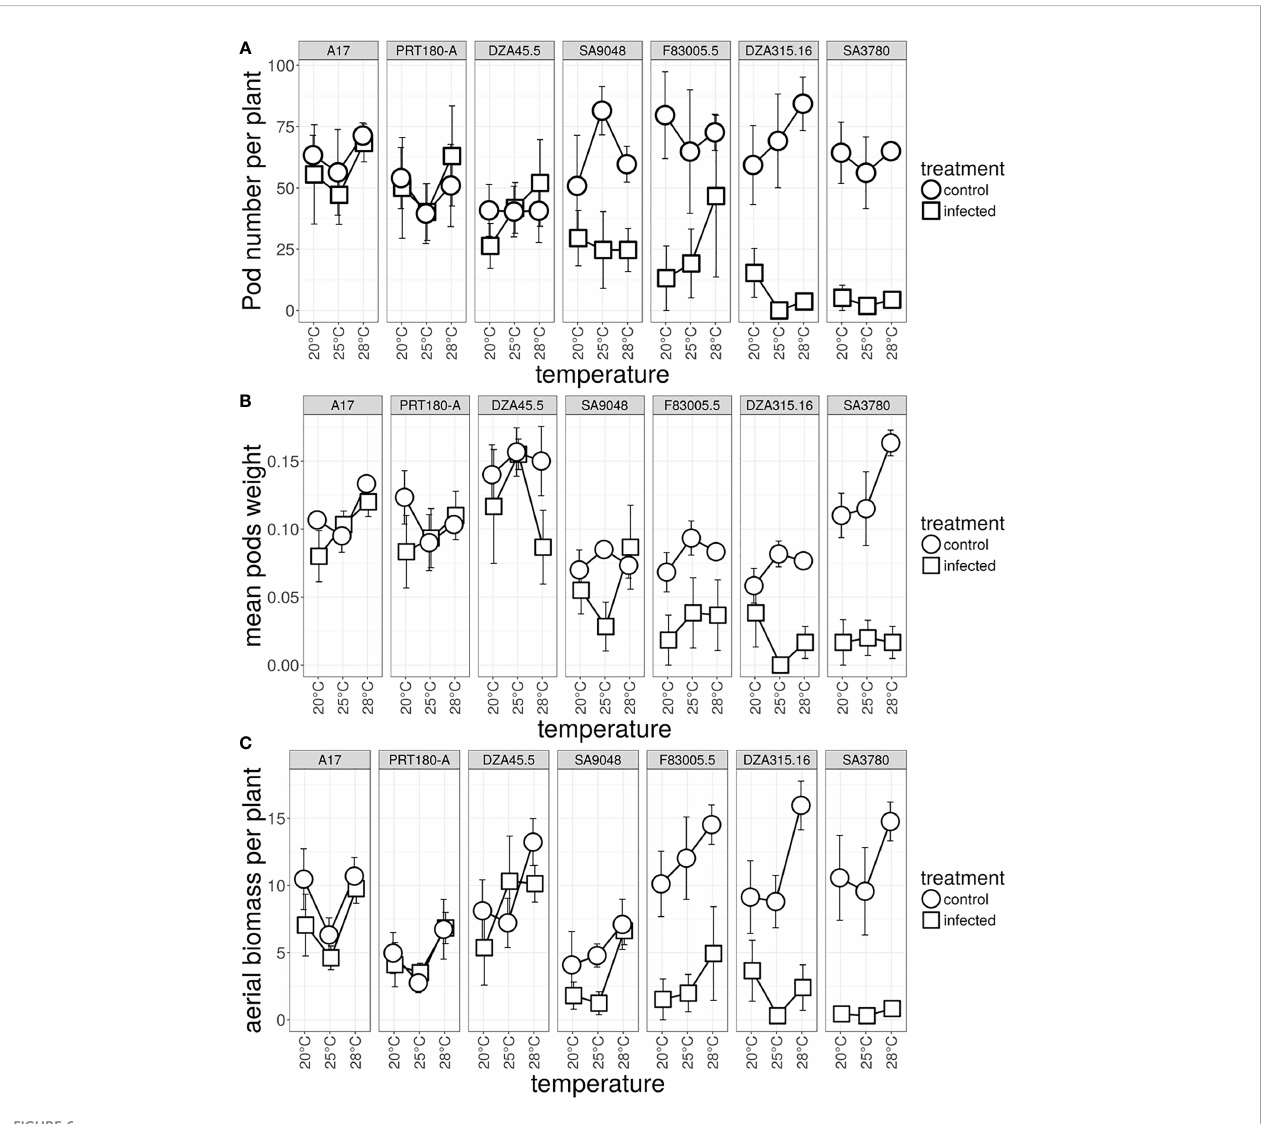
FIGURE 6 Effect of temperature on total lifetime fi tness of M. truncatula inoculated, or not, with Verticillium strain V31-2. The M. truncatula lines A17, PRT180-A, DZA45.5, SA09048, F83005.5, DZA315,16 and SA03780 were mock-inoculated or root-inoculated with a spore suspension of Verticillium strain V31-2 and maintained at 20°C,25°C and 28°C during one month, then transferred to the greenhouse. The greenhouse conditions were identical for all plants. (A) pod number (B) pod weight and (C) weight of dry aerial mass were measured at the end of the plant ’ s cycle (approx. six months). Bars indicate standard error of the means of two independent experiments, with three blocks